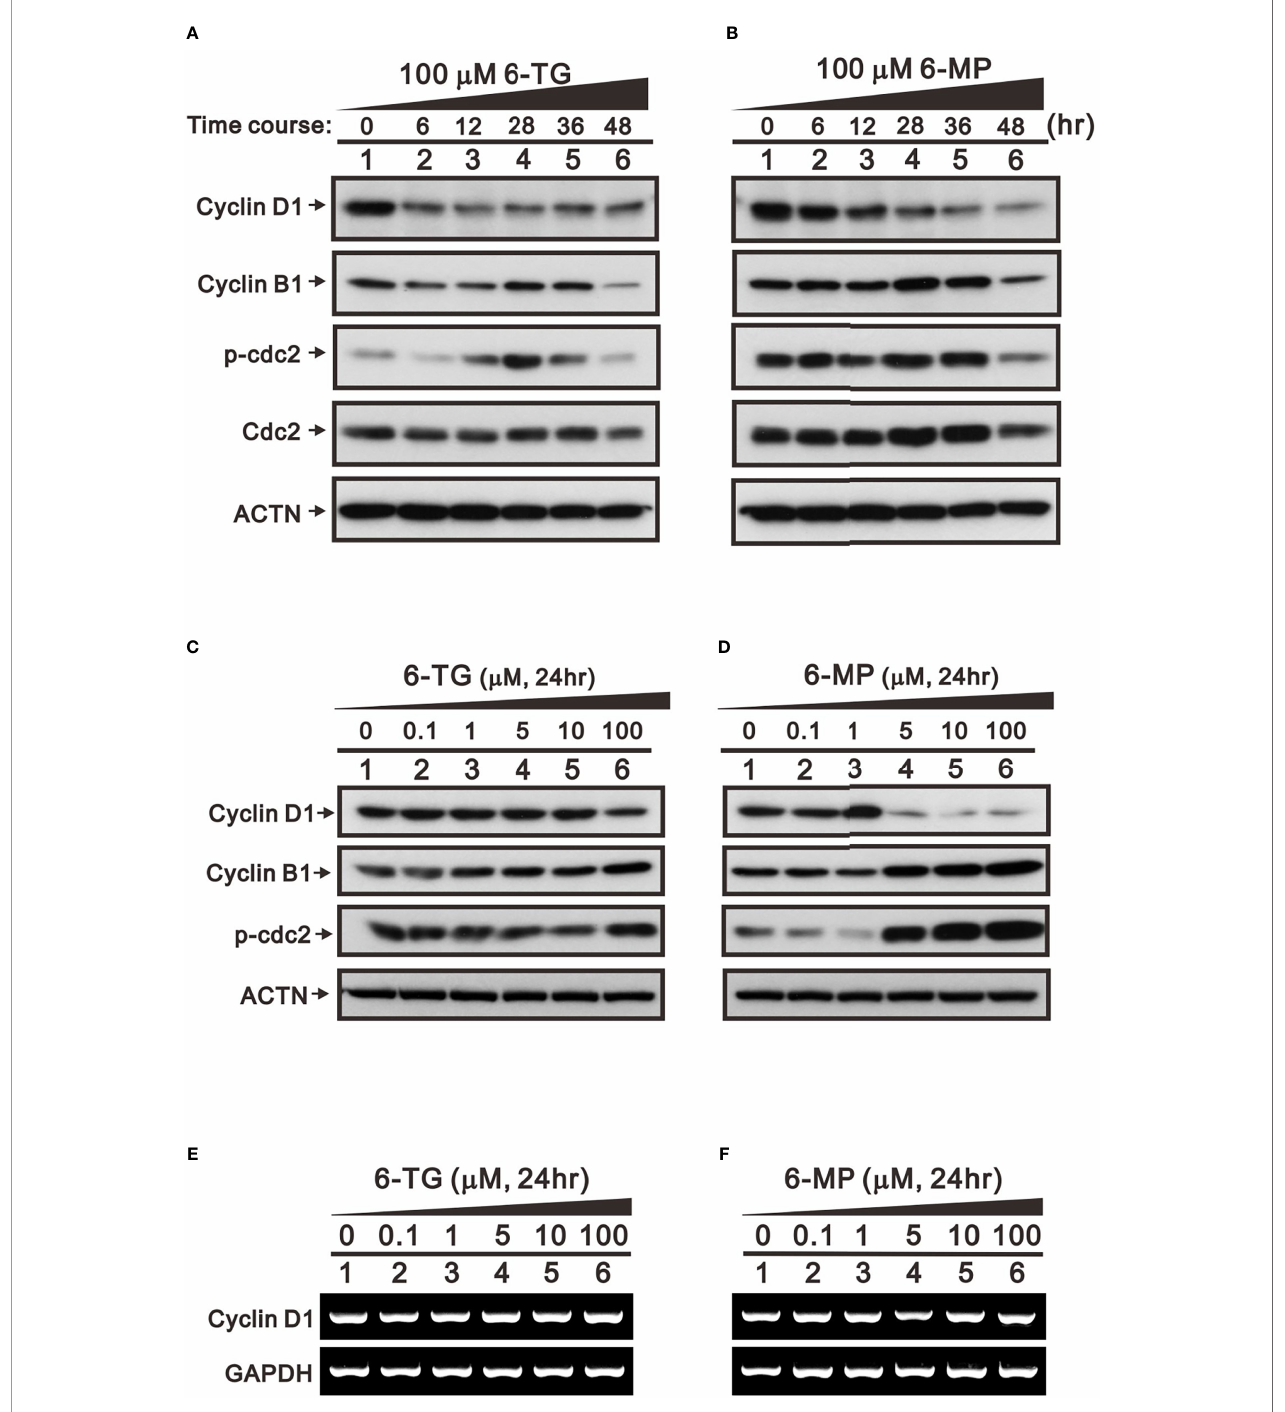
FIGURE 5 | Time- and dose-dependent effects of 6-TG and 6-MP on expression of cell cycle-related proteins in A253 cells. Cells were treated for the indicated times (A, B) with 100 m M 6-TG or 6-MP or for 24 h (C – F) with the indicated concentration of 6-TG or 6 ‐ MP. (A – D) Cell lysates were then subjected Western blotting analysis with antibodies against the indicated proteins. ACTN is a protein loading control. (E, F) Cell lysates were subjected to the RT-PCR analysis for cyclin D1 mRNA. GAPDH is an mRNA loading